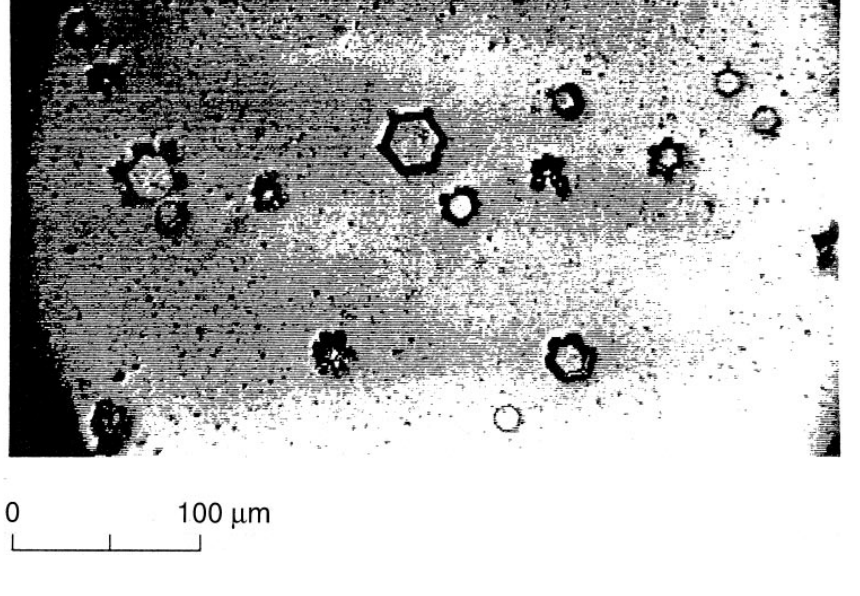
Fig. 15. Photograph of ice crystals collected on Formar coated slides in the cold chamber